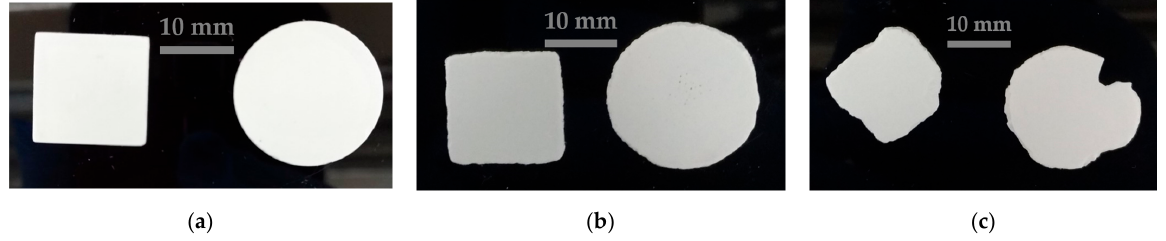
Figure 11. DLP printed part with 25 µm as layer thickness, 3 s exposure time, and exposure power of ( a ) 50‰; ( b ) 100‰; ( c ) 150‰.